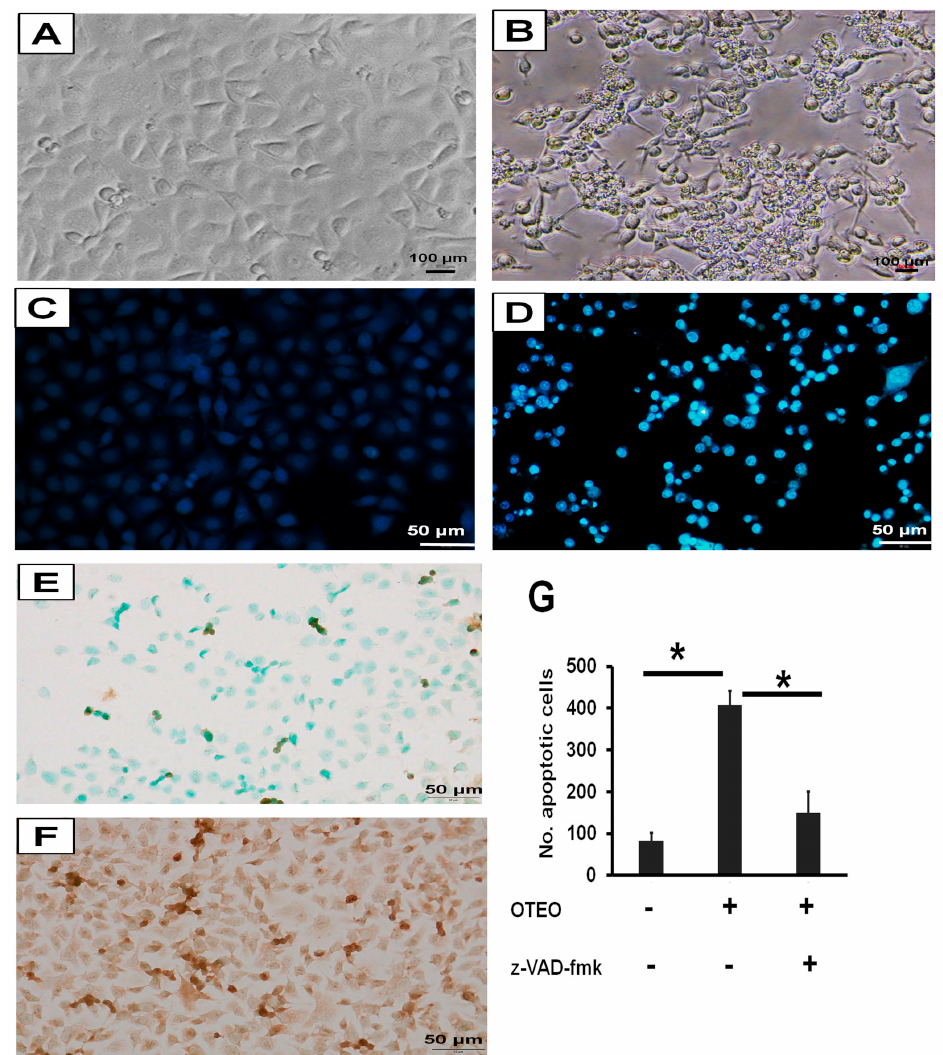
Figure 4. Determination of cell and nuclear morphology in AGS cells. ( A , B ) Cell morphology observed under inverted microscope. ( C , D ) Nuclear morphology determined by DAPI staining.